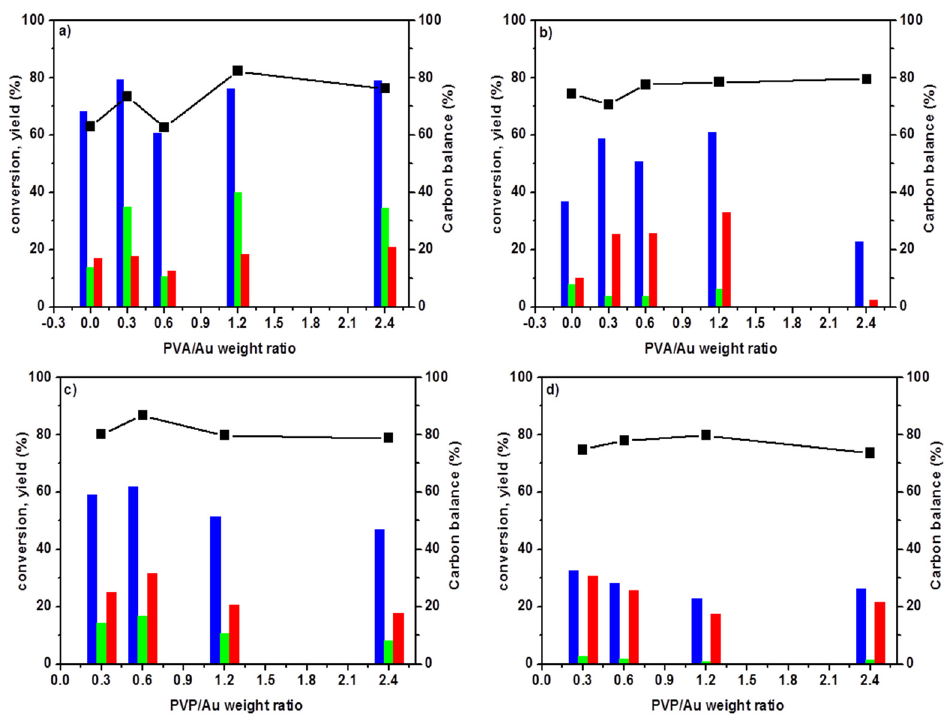
Figure 2. Conversion and yield to products as function of ( a , b ) PVA and ( c , d ) PVP stabilizer by using ( a , c ) nHDO/nAu = 50 and ( b , d ) nHDO/nAu = 100: ( ■ ) HDO conversion, ( ■ ) AA yield, ( ■ ) HHA Yield, ( ■ ) Carbon balance. Reaction conditions: 2 mL solution of HDO (42 mmol L − 1 ), 110 °C, 15 bar air, 4 h, 600 rpm.